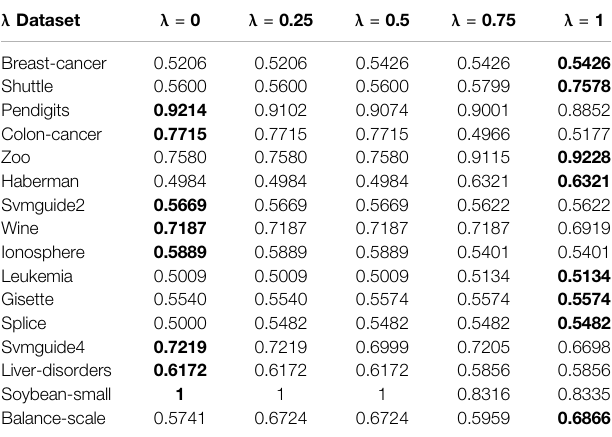
TABLE 4 | AIMK Runs on 16 datasets, Measured by RI. λ Dataset